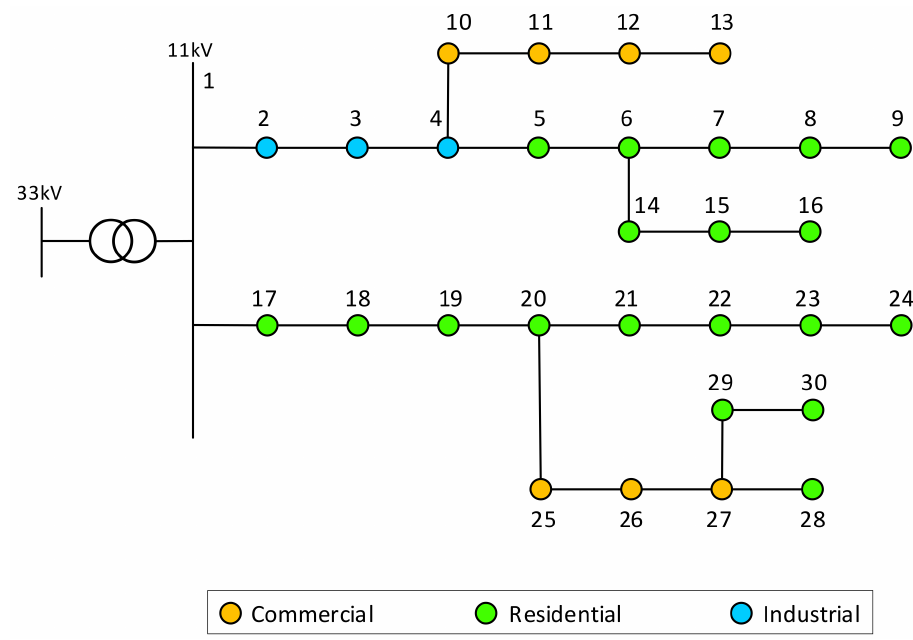
Figure 4. Single line diagram of the test network.